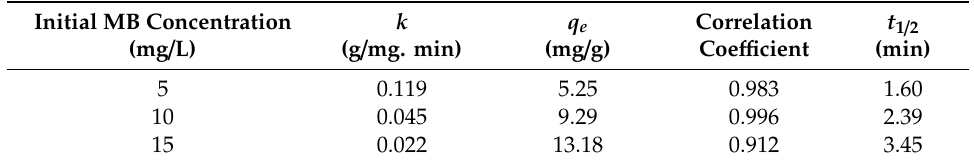
Table 3. Adsorption kinetic parameters for the adsorption of methylene blue (MB) onto the optimal biochar (CPH-BC-800-AW). a.